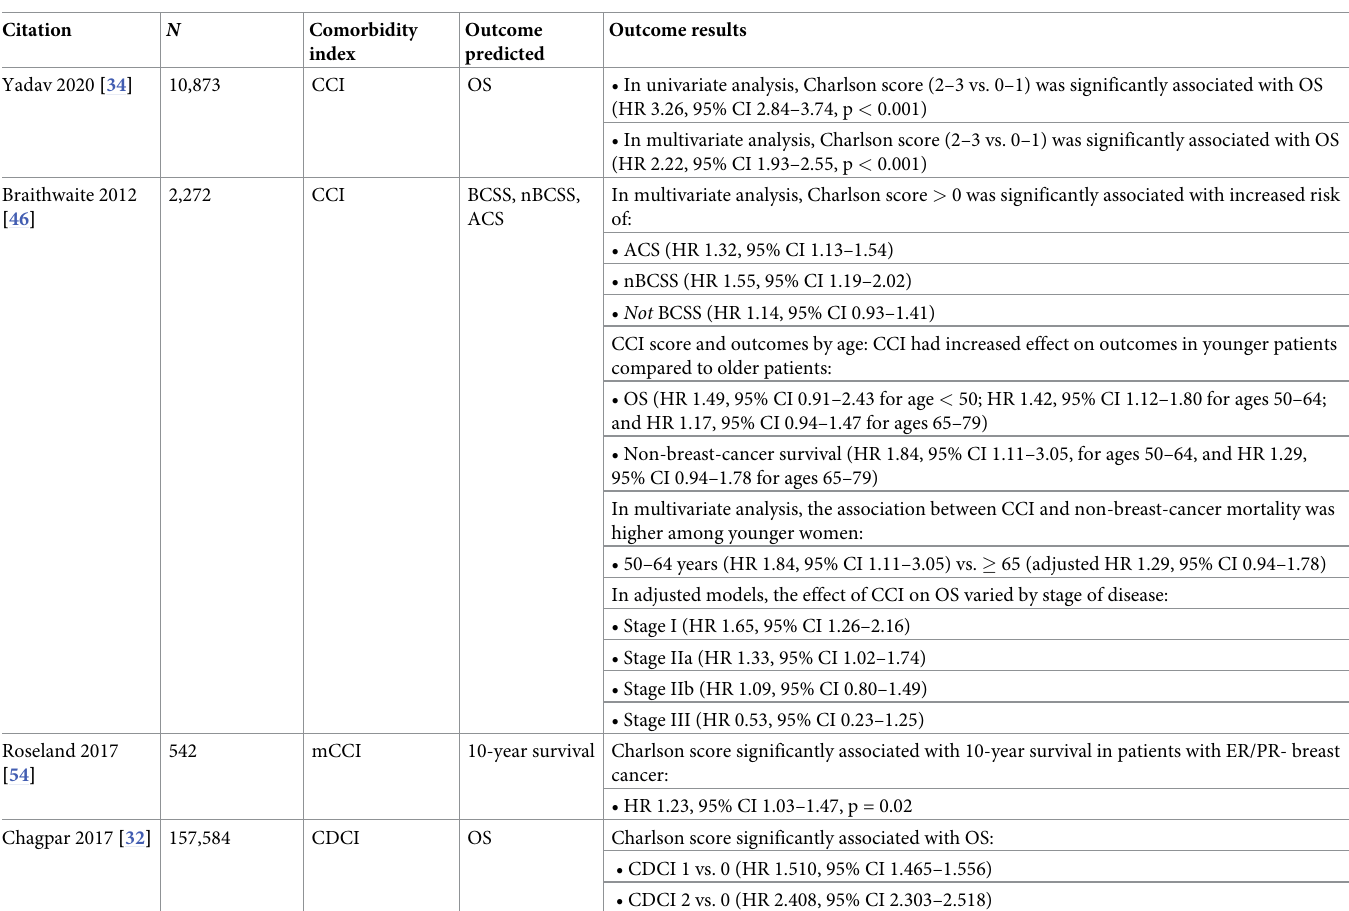
data set. ACE-27, derived from the Kaplan-Feinstein Comorbidity Index, is a validated chart- based comorbidity index specifically designed for patients with cancer